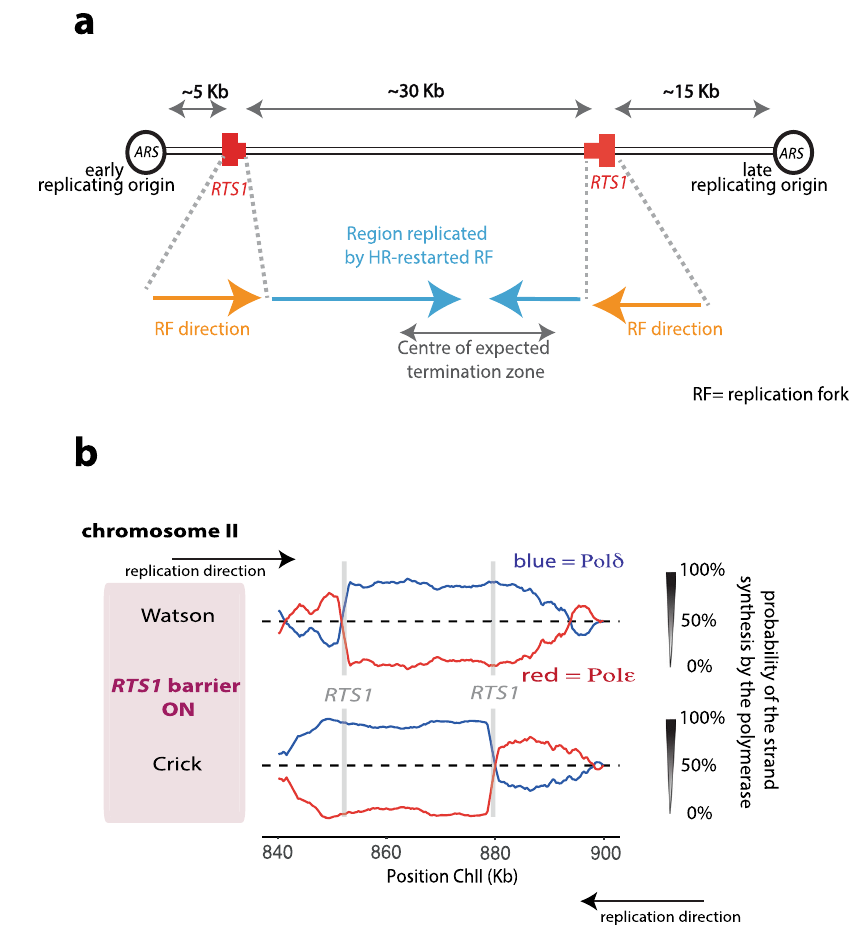
Fig. 2 HR-restarted replication does not mature from the δ / δ to ε / δ con fi guration. a Schematic of the inverted RTS1 locus on chromosome II. The positions of the directional RTS1 barriers are shown in red, with the thick bar indicating the directionality of fork arrest. b Pu-seq traces from the modi fi ed locus when the barrier is active (adh- rtf1 + ). Note: the transition from Pol ε (red) to Pol δ (blue) on the Watson strand at the left-side RTS1 site and the transition from Pol ε to Pol δ on the Crick strand at right-side RTS1